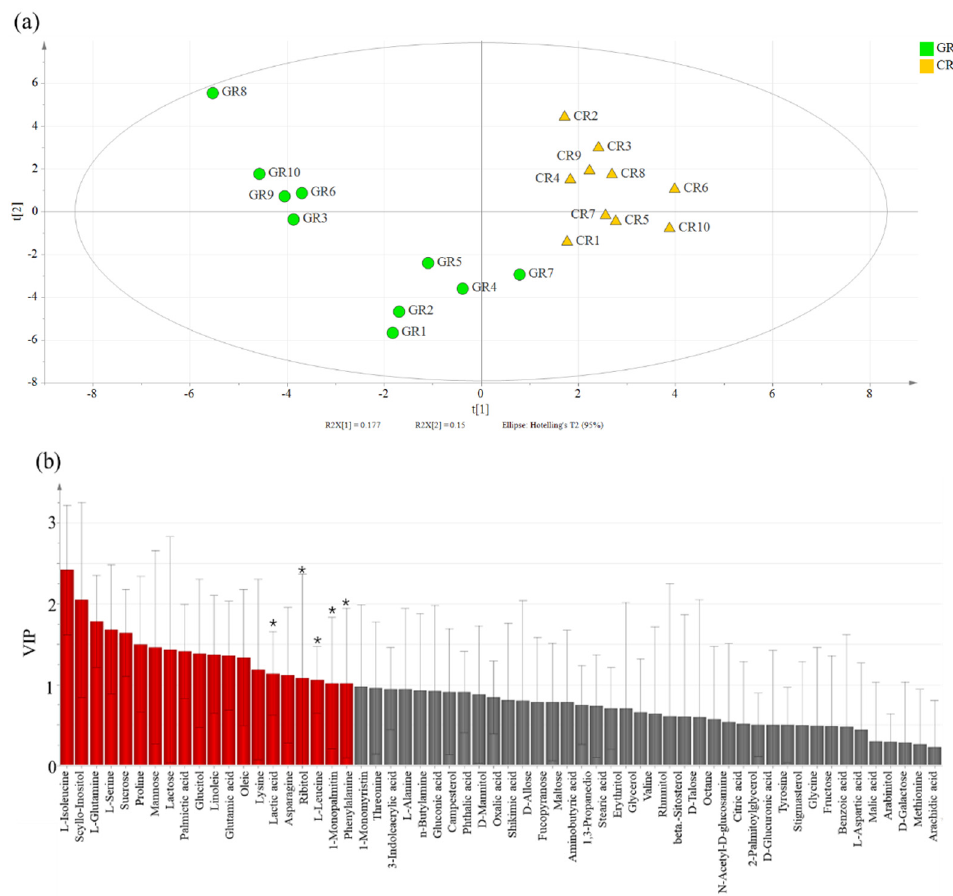
Figure 2. Partial least squares-discriminant analysis (PLS-DA) score plot ( a ) of primary metabolites identified by GC–MS. ( b ) Metabolites ( b ) that were differentially expressed between GR (green rice) and CR (conventional rice) with a VIP > 1.0 were considered significant. * denotes p > 0.05 (insignificant).